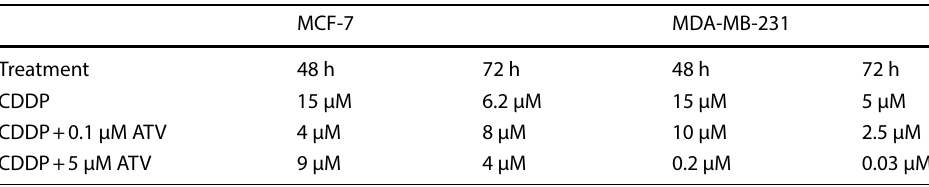
Table 1 IC values for CDDP 50 either alone or in combination with ATV following 48 and 72 h exposure in MCF-7 and